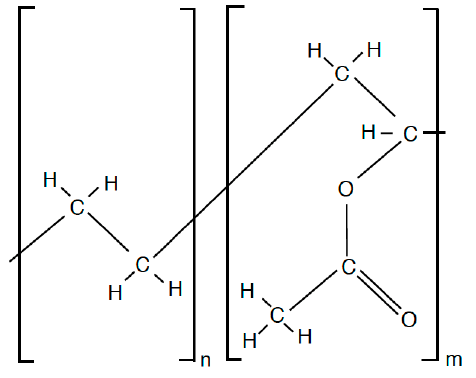
Figure 4. EVA Chemical Structure.